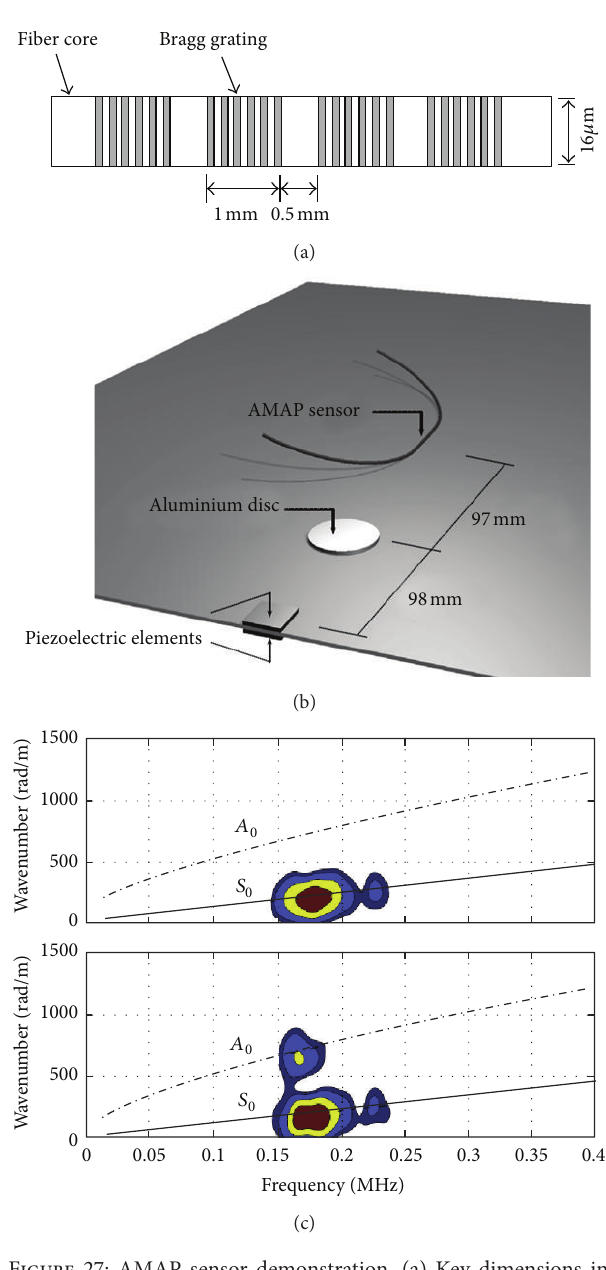
Figure 27: AMAP sensor demonstration. (a) Key dimensions in a section of the optical fiber core in the AMAP sensor; (b) test panel made of an aluminum alloy with the wave generation element, AMAP sensor, and bonded disc, attached to simulate a damage, as a source of reflected waves; (c) spectral decomposition of the AMAP sensor response measured for a selectively excited 𝑆 0 mode in the absence of the bonded disc (top) and after attachment of the disc (bottom)